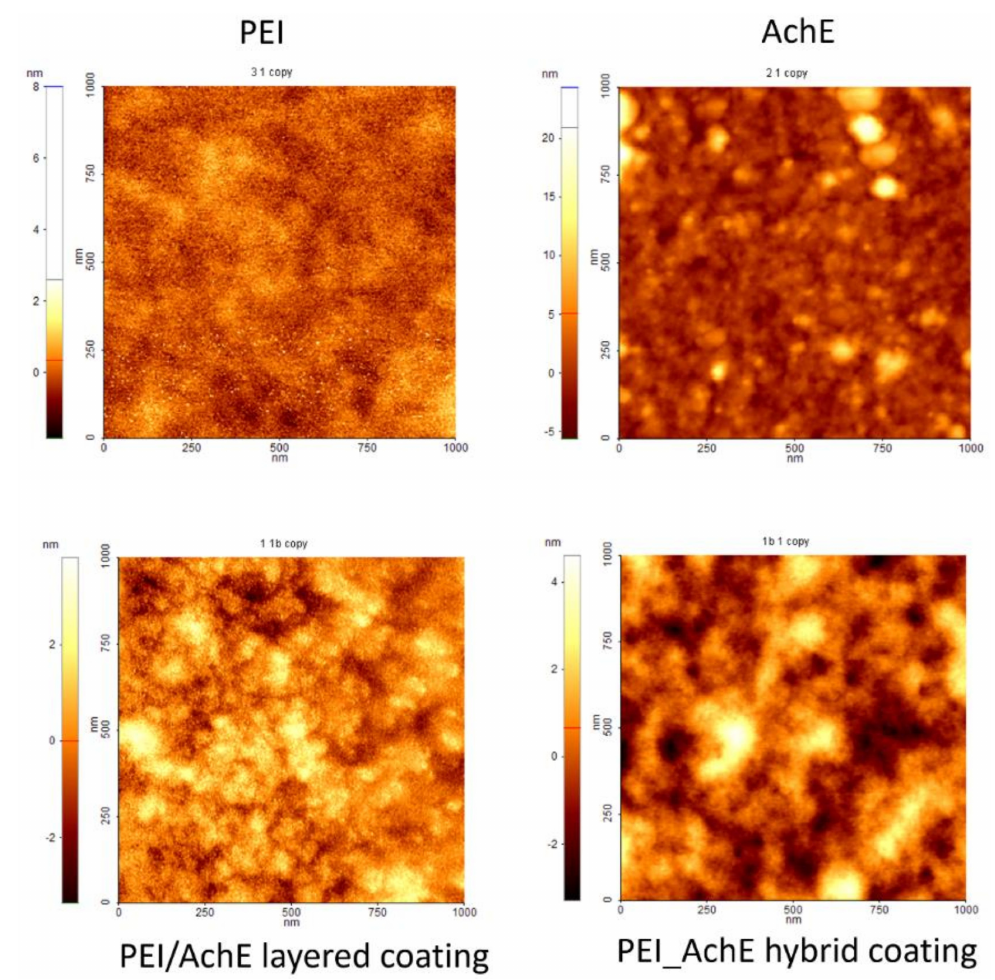
Figure 5. The AFM analysis of the MAPLE-coated samples (1 µ m × 1 µ